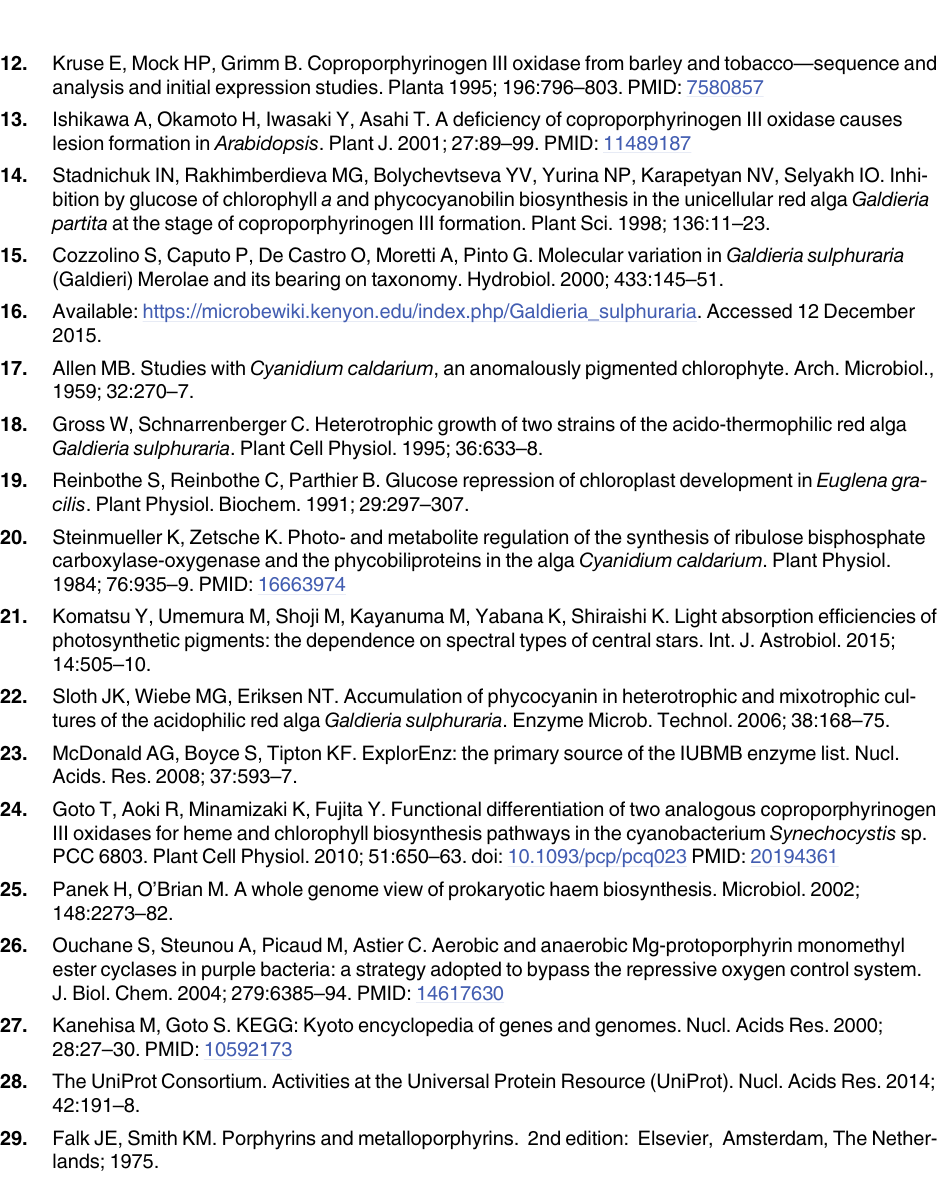
PLOS ONE | DOI:10.1371/journal.pone.0148358 February 9, 2016 10 /